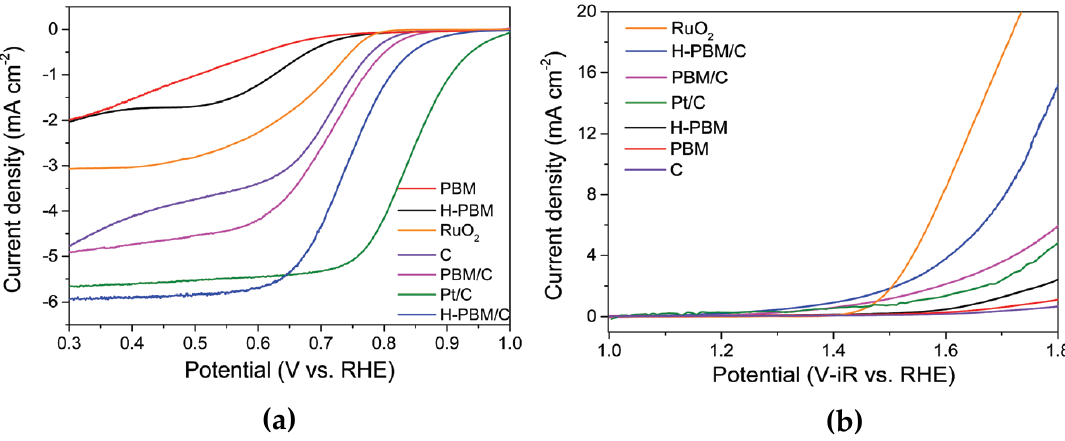
Figure 11. ( a ) ORR ( b ) OER polarization curves of PBM, H-PBM, RuO 2 , C, PBM/C, Pt/C, and H-PBM/C in O 2 -saturated alkaline solution (rotating speed: 2000 rpm; scan rate: 5 mV s − 1 ; electrolyte: 0.1 M KOH). Copyright 2016 by the Royal Society of Chemistry [89].